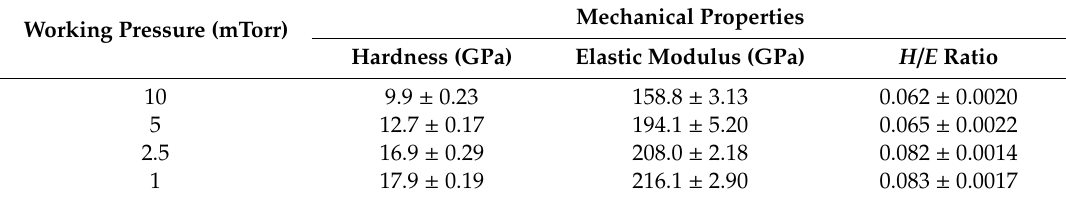
Table 3. Hardness, elastic modulus, and H / E of the Mo–Si–N coatings deposited at working pressures of 10, 5, 2.5, and 1 mTorr, retaining a N 2 gas flow ratio of 25%.